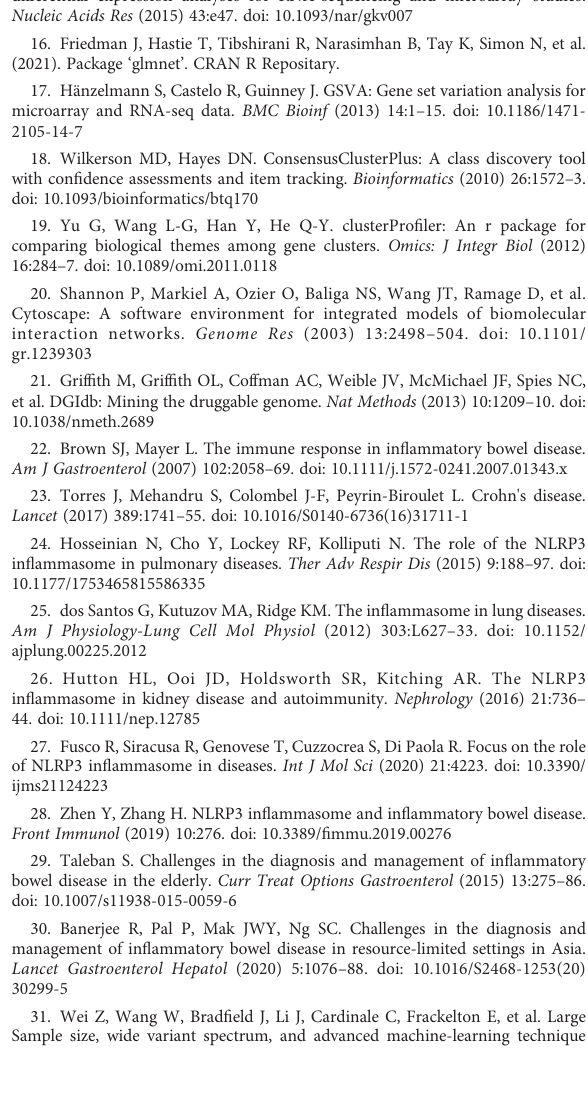
SUPPLEMENTARY FIGURE 1 Clinicopathological characteristics of two